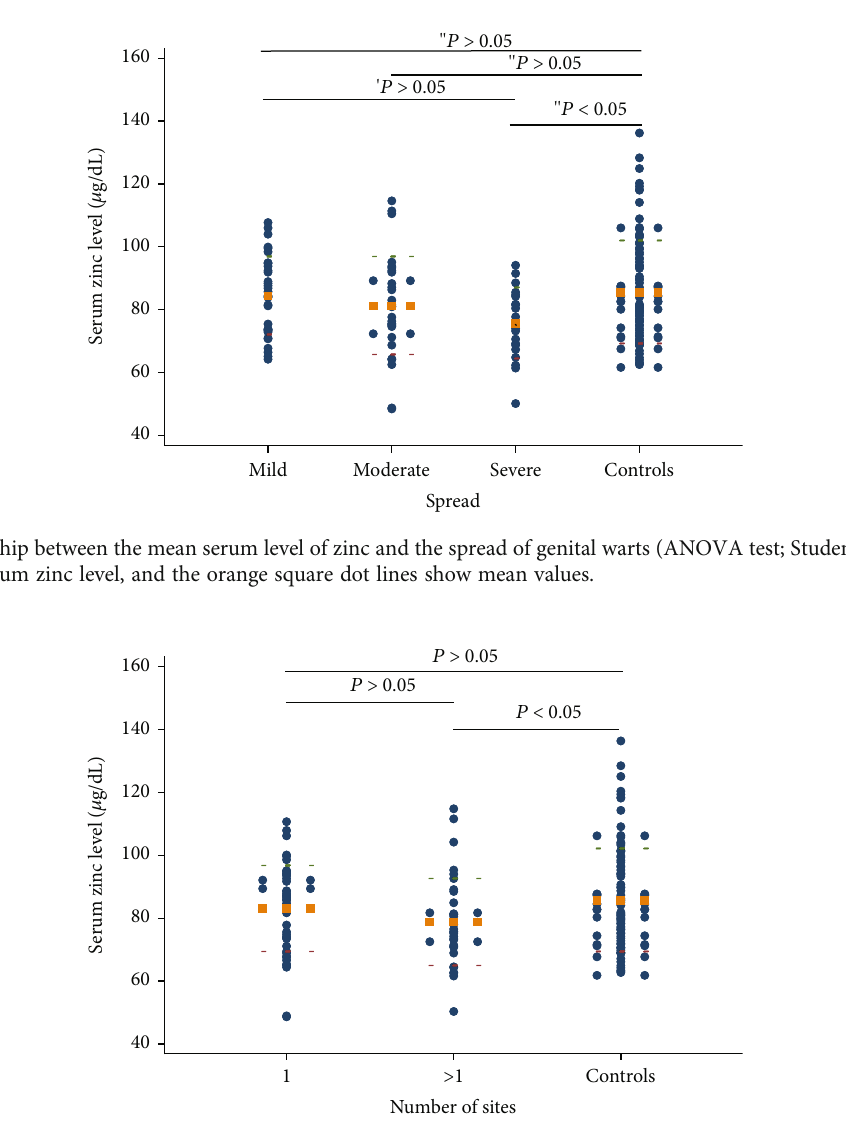
Figure 3: The serum level of zinc in relation to the number of sites a ff ected (Student ’ s t -test). The round dots show values of serum zinc level, and the orange square dot lines show mean